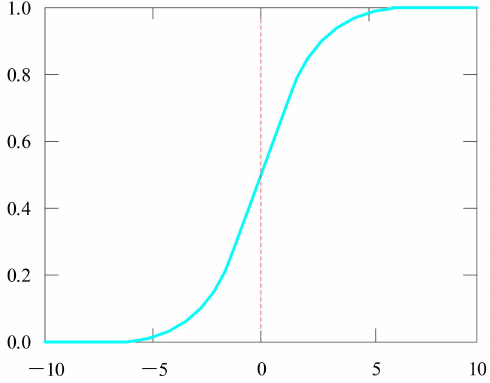
Figure 10. Sigmoid curve image.